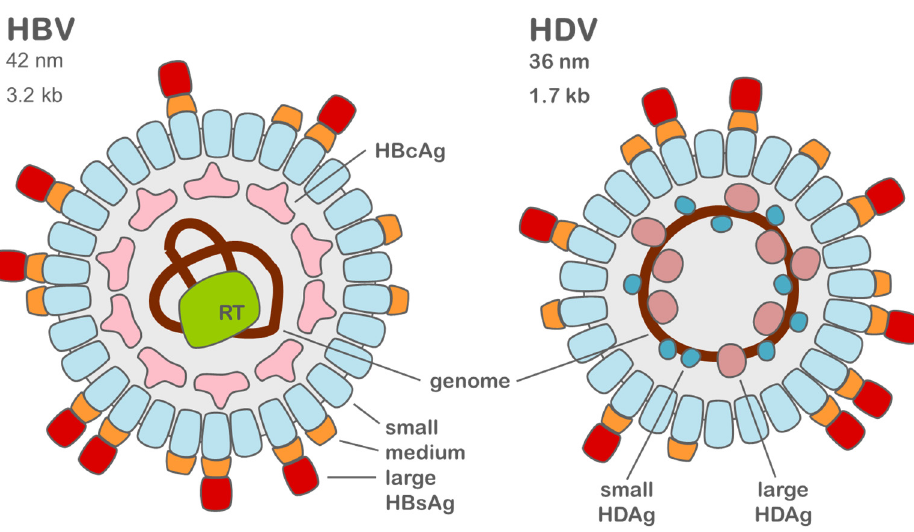
Figure 1. Comparison of HBV and HDV. Both viral envelopes consist of small, medium, and large HBsAg. HBcAg forms the HBV capsid which encloses the reverse transcriptase and the HBV genome. In the HDV particle, the envelope proteins enclose the ribonucleoprotein consisting of the genome and the small and large HDAg.